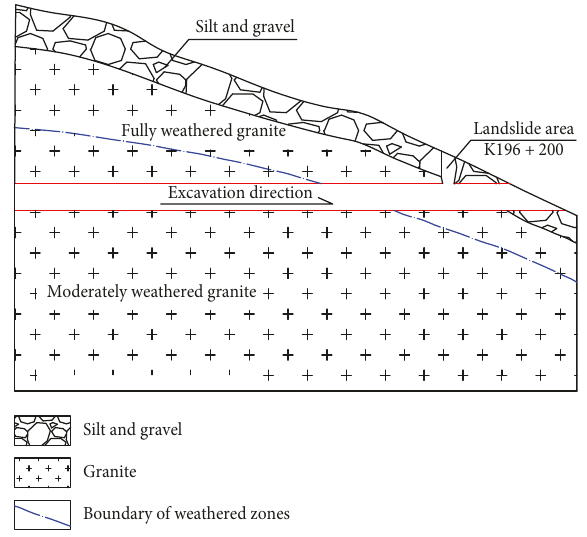
Figure 4: Slope geography and rock soil distribution.